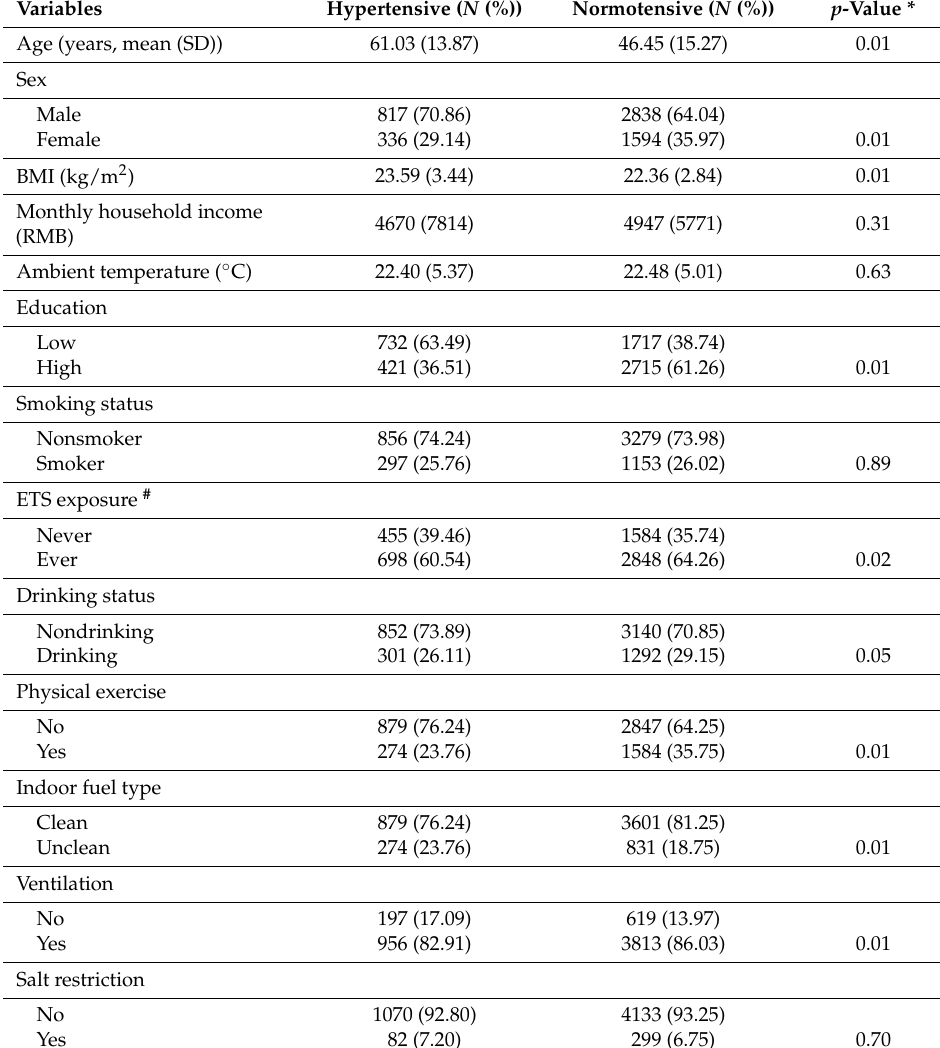
Table 1. Comparison of socio-demographic and major risk factors between 1153 hypertensive subjects and 4432 normotensive subjects in Guangdong,